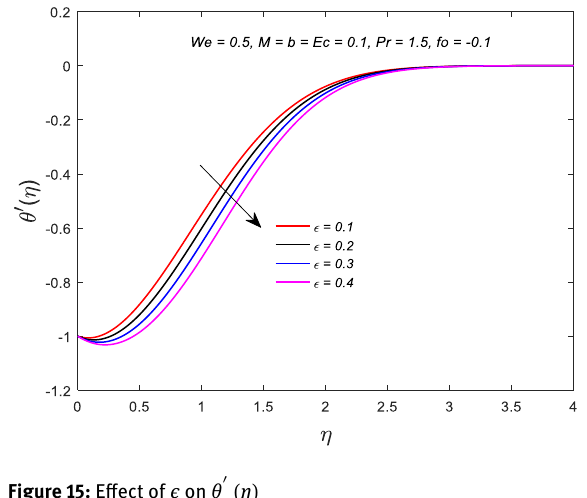
Figure 15: Effect of ϵ on θ (cid:48) ( η )